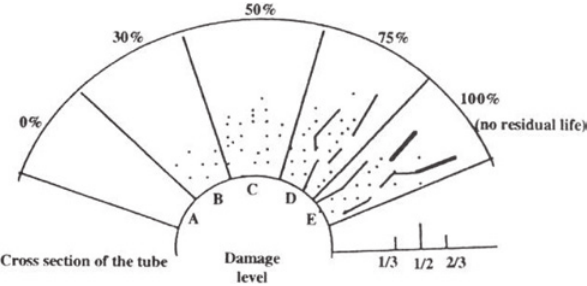
Fig. 8: Classification of damage in wall of a reformer tube, as indicated after metallographic preparation